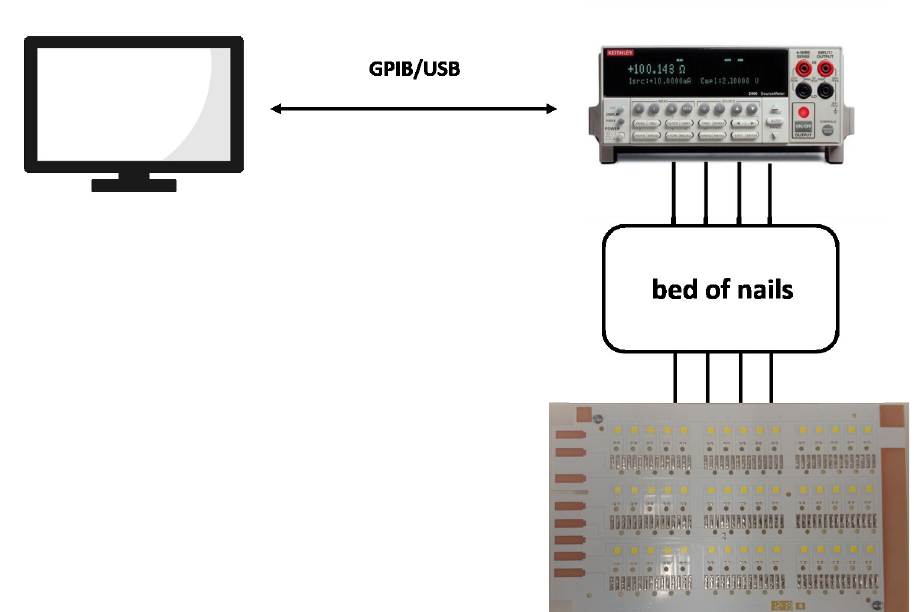
Figure 1. Instrumentation used in the experimental protocol. The PC was connected to the Source Meter Unit (SMU) with General Purpose Interface Bus—Universal Serial Bus (GPIB-USB), the SMU and bed of nails were linked with a 4-wire connection, and the bed of nails created the electrical connection with the DUT via 4 spring